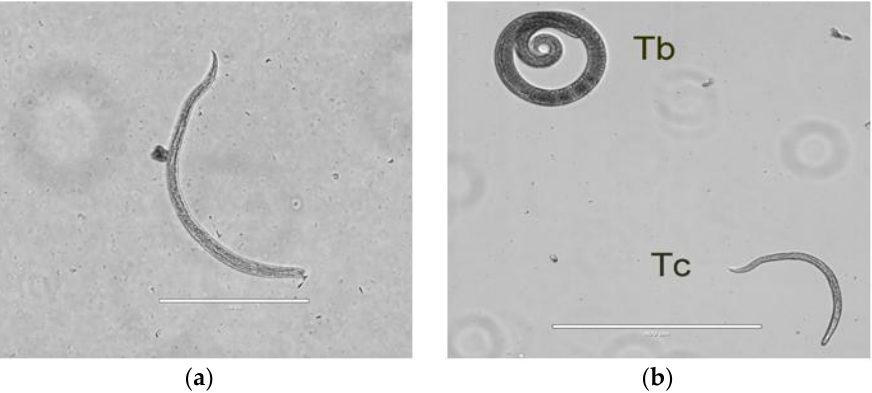
Figure 1. Larva of Toxocara cati isolated from common buzzard ( Buteo buteo ) (scale bar 200 µ m) ( a ). Larva of Toxocara cati (TC) isolated from the red kite ( Milvus milvus ) compared with a larva of Trichinella britovi (TB) (scale bar 400 µ m) ( b ).